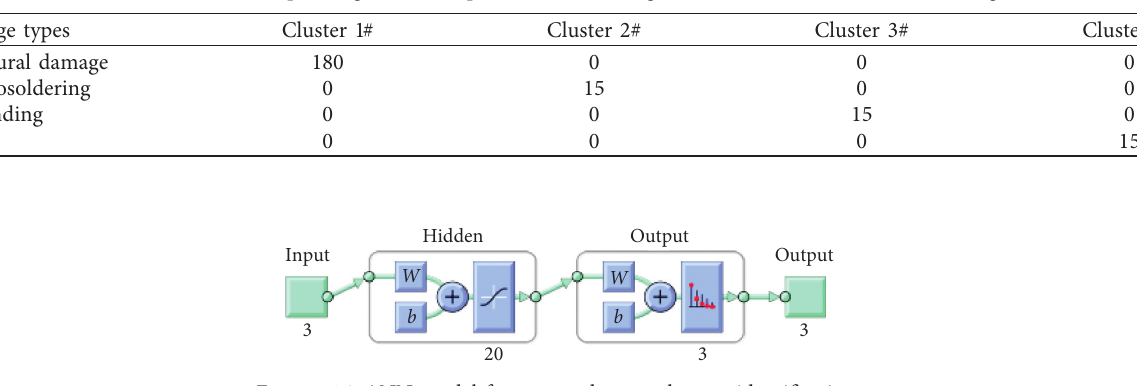
Table 4: The corresponding relationship between clustering results and different kinds of damage.